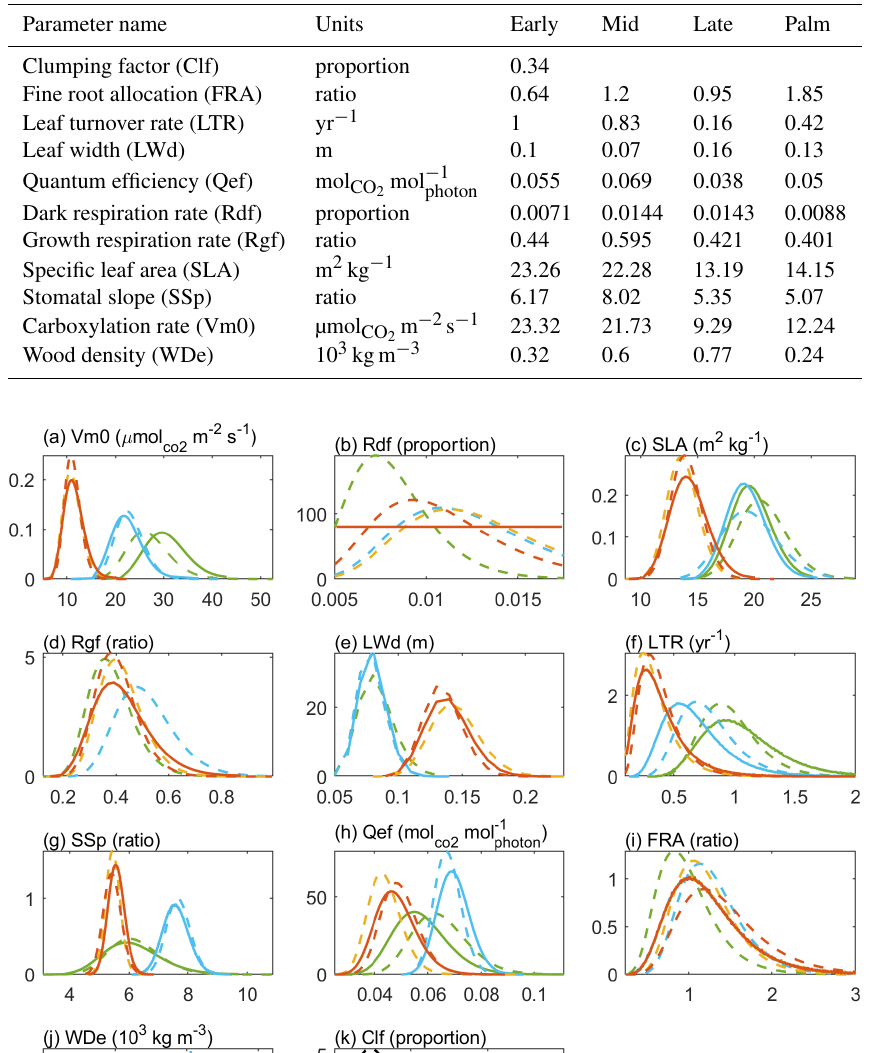
Table 1. The optimal parameter set obtained from the GLUE method.